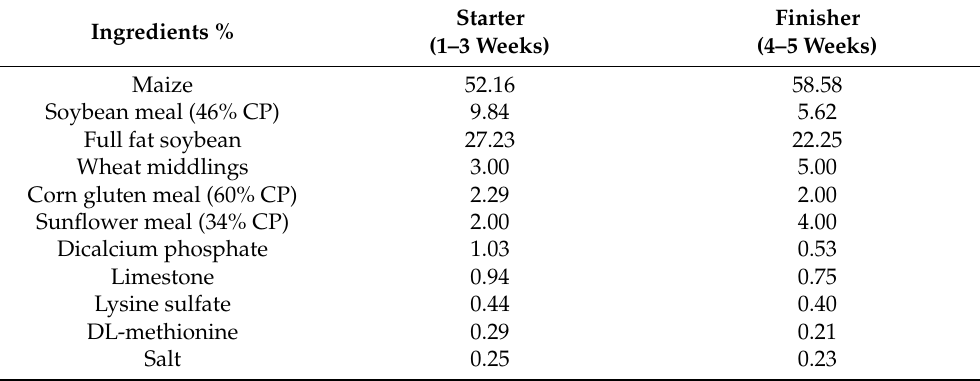
Table 1. Standard basal